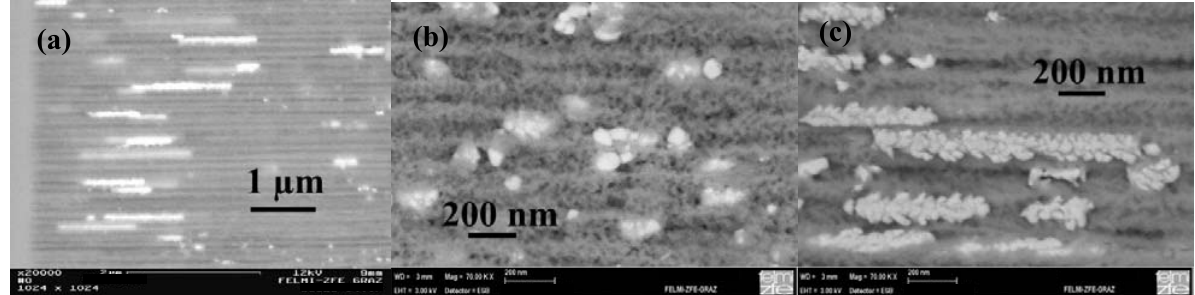
Figure 22. (a) Cross-sectional scanning electron micrographs obtained from the back scattered electrons of Ni-nanowires deposited within the channels of the PS matrix. The elongation of the wires exhibits about 1.5 µm and the average diameter is according to the mean pore-diameter of 55 nm [84]. (b) Precipitated Co-particles within the PS-template. The particle sizes are distributed between spheres of about 60 nm and ellipsoids with a maximum length of 150 nm [84]. (c) NiCo-nanostructures within the pores exhibiting a maximum length of 500 nm. The variation of the length of the precipitations lies between 200 nm and 500 nm